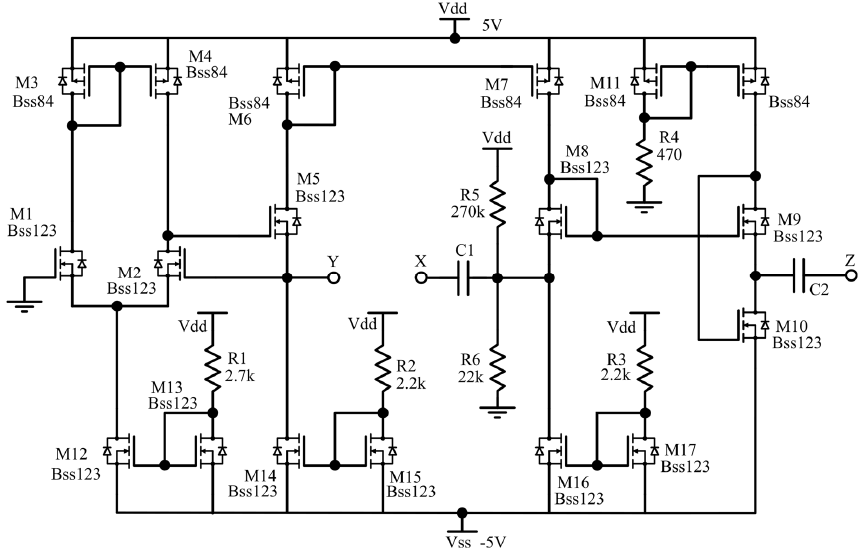
Figure 4. Complete schematic of the defined VCII in SPICE Environment.